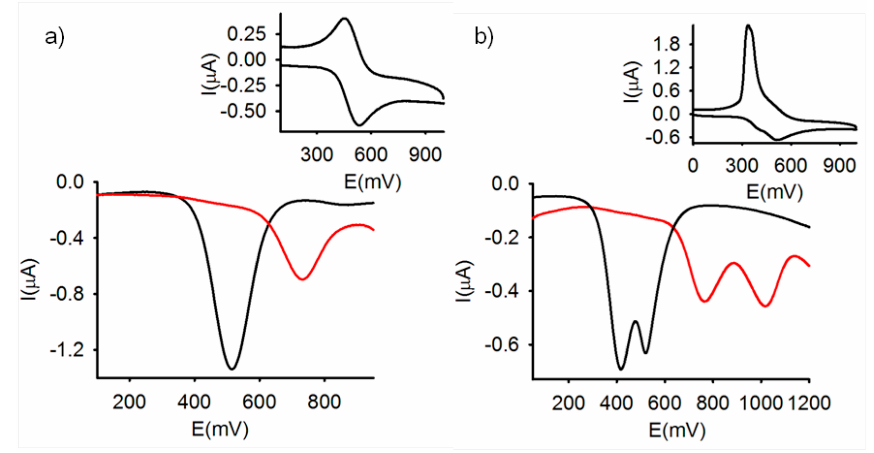
Figure 1. Evolution of the OSWV for the receptors 3 ( a ) and 4 ( b ) in CH (black line) upon addition of 1.4 equiv of Pb 2+ (2.5·× 10 − 2 M en CH [ n -Bu N]PF as supporting electrolyte. In inset, the corresponding CVs for both receptors 4 6 are